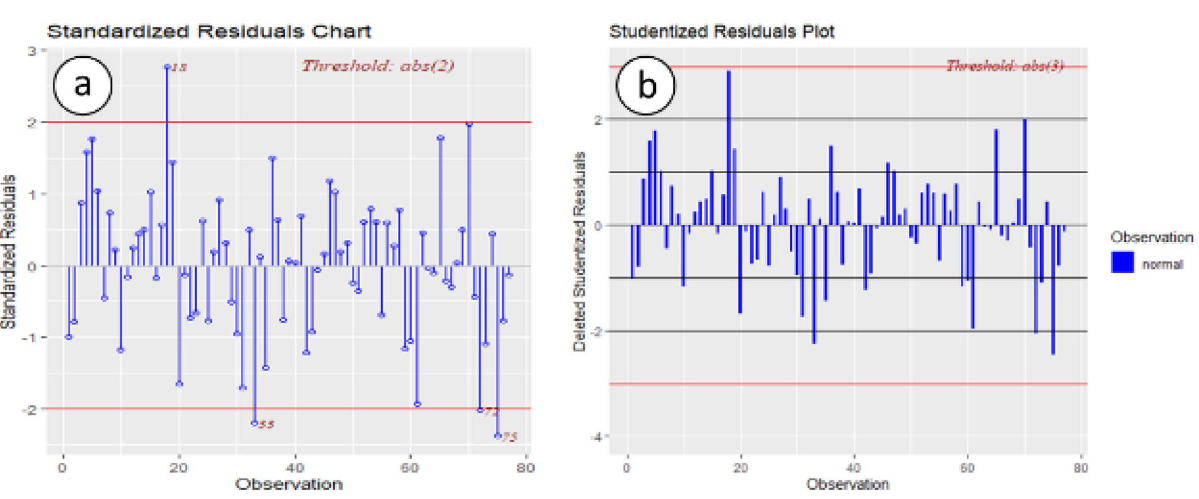
Figure 8. ( a ) Standardized residuals, ( b ) studentized